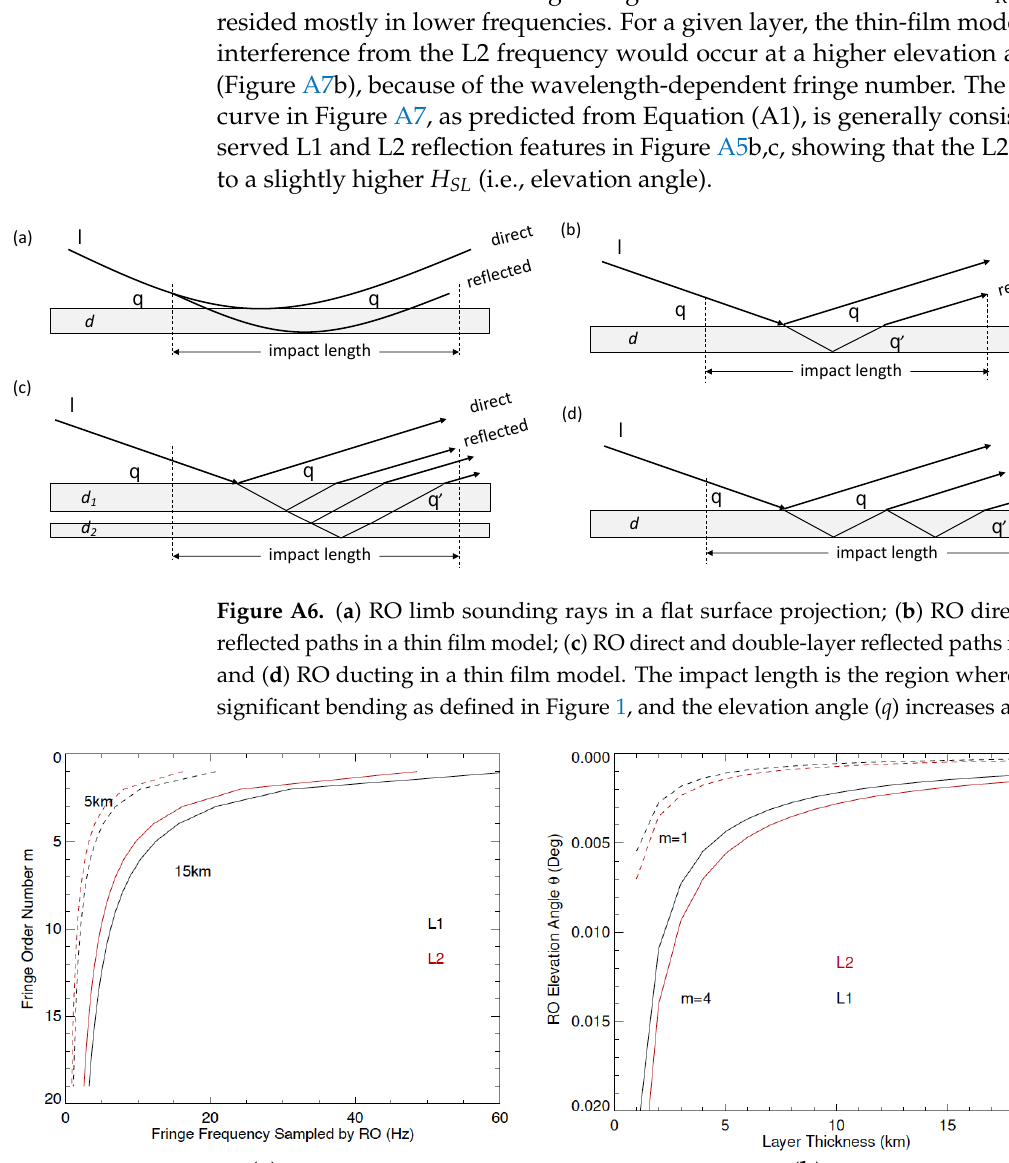
Figure A7. RO grazing angle interference patterns predicted from a single-layer thin-film model: ( a ) Fringe number m as a function of RO sampling frequency; ( b ) RO elevation angle q as a function of layer thickness d . A RO setting rate of 1.3 km/s is used for the calculations in ( a ), where two thicknesses (5 and 15 km) are illustrated. Two fringe numbers ( m = 1 and m = 4) are illustrated in ( b